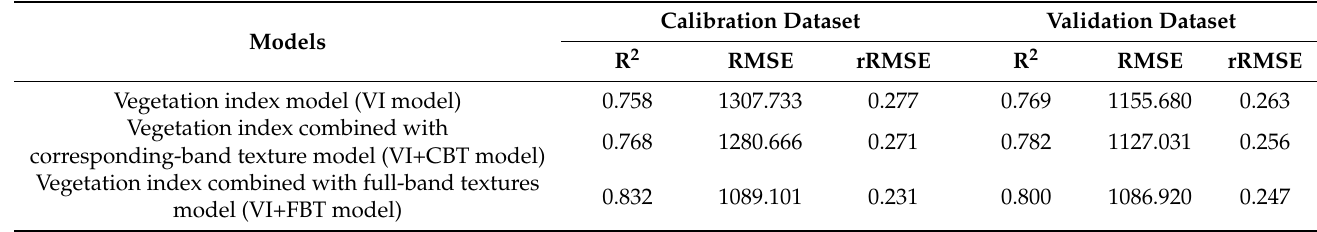
Table 6. Comparisons of the accuracy of three AGB